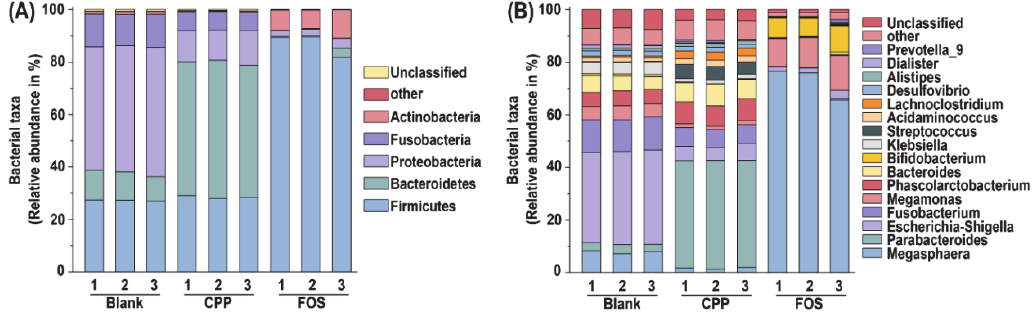
Figure 4. The relative abundance at the phylum level ( A ) and genus level ( B ).